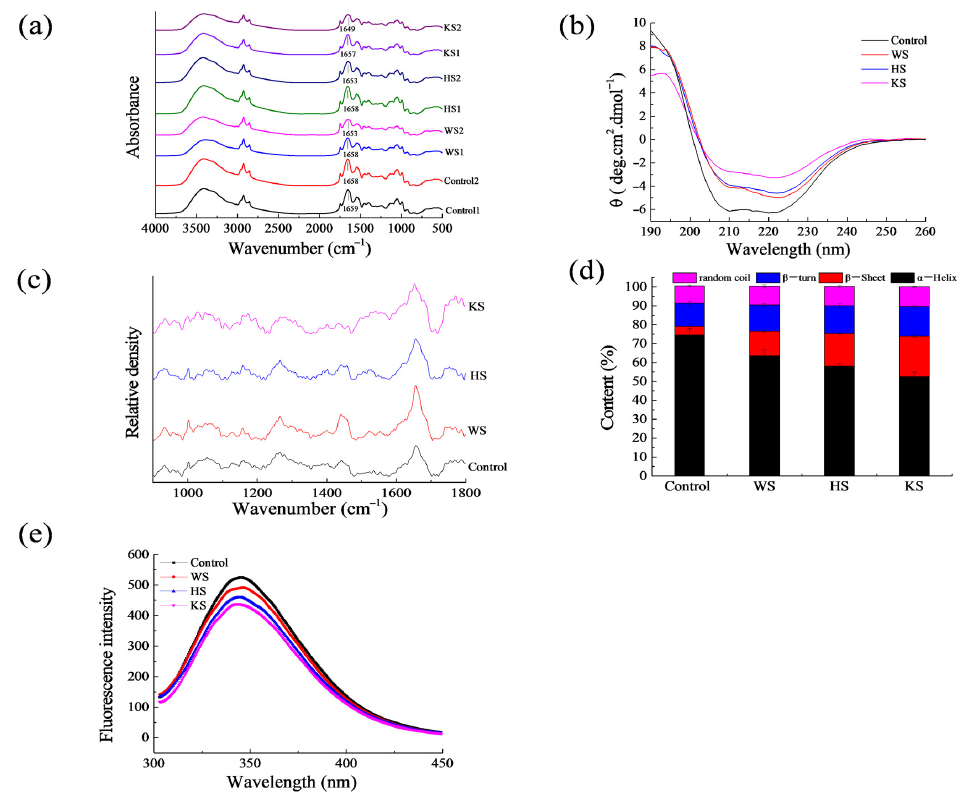
Figure 2. Changes in structure of myofibrillar protein (MP) with different treatments. ( a ): FTIR spectra; ( b ): Circular dichroism; ( c ): Raman spectra ( d ): Raman spectra secondary structure content; ( e ): Fluorescence intensity; Control: Surimi (75%) + water (25%); WS: Surimi (75%) + wakame slurry (25%); HS: Surimi (75%) + hijiki slurry (25%); KS: Surimi (75%) + kelp slurry (25%); Values are expressed as the means ± SD and results are representative of at least three independent